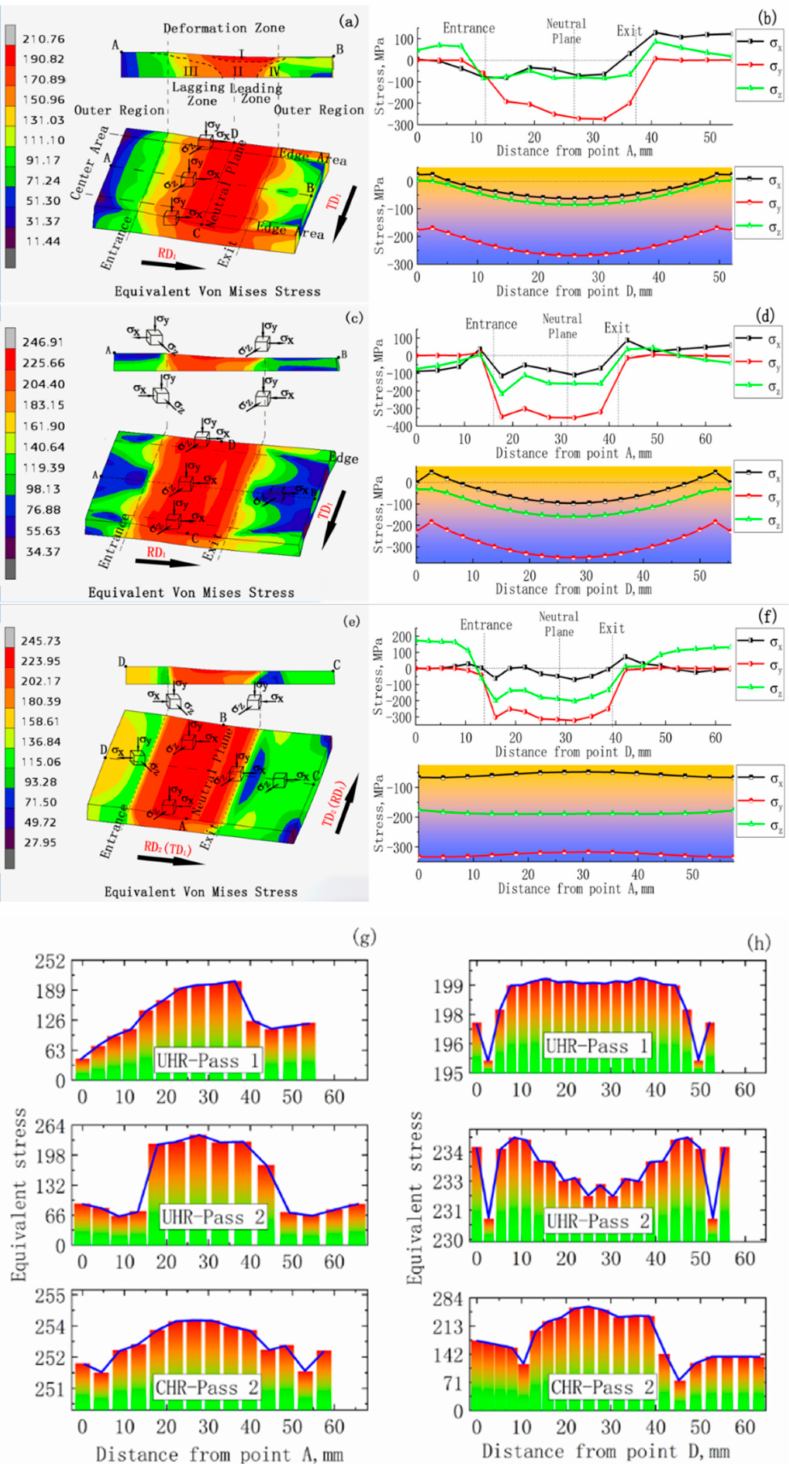
Figure 6. Equivalent stress distribution in rolling deformation zone: ( a ) the first pass of UHR; ( c ) the second pass of UHR; ( e ) the second pass of CHR; ( b , d , f ) additional stress distributions along AB and DC for each of the above passes; ( g , h ) equivalent stress curves of different passes along AB and